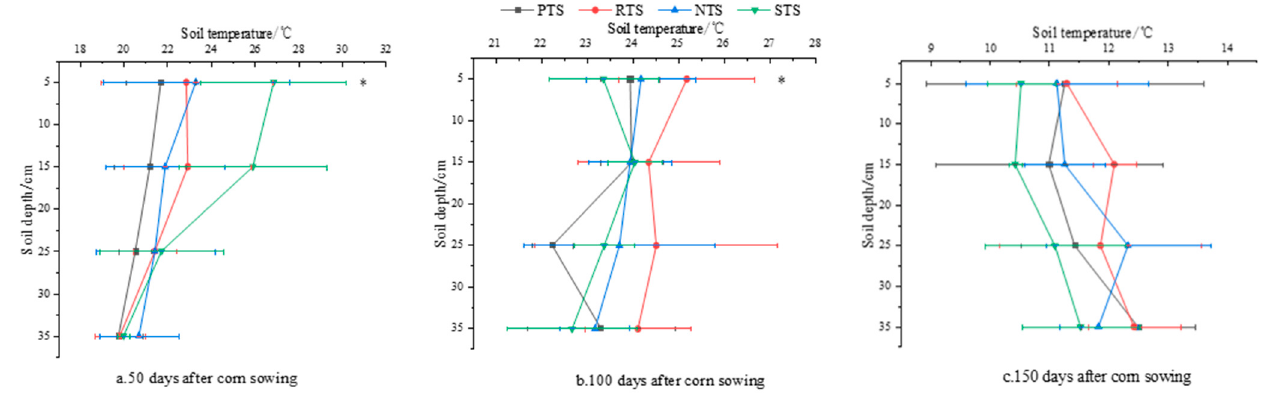
Figure 3. Effect of tillage and sowing methods on soil temperature.